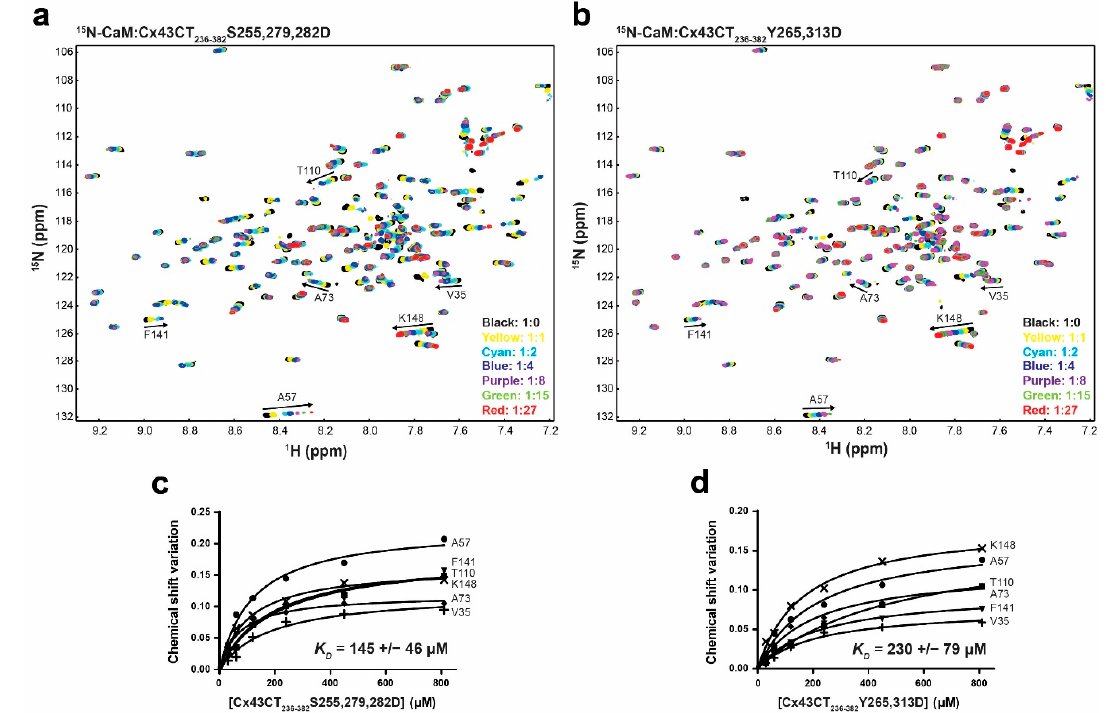
Figure 8. Effect of Cx43CT phosphorylation by MAPK and Pyk2/Src on the interaction with CaM. 15 N-HSQC spectrum of 15 N-labeled CaM alone (black) has been overlaid with spectra collected in the presence of increasing molar ratios of unlabeled Cx43CT 236-382 with ( a ) MAPK S255,279,282D or ( b ) Pyk2/Src Y265,313D phosphomimetic mutants (ratios indicated in the lower right corner). The residues used to calculate the dissociation constant (K D , panel c and d ) have been labeled. Changes in chemical shift ( Δσ ) plotted as a function of the Cx43CT 236-382 ( c ) MAPK or ( d ) Src phosphomimetic mutants. Overall K D and standard deviation were calculated by averaging the individual K D obtained for each residue after plotting and linear fitting their Δσ values.